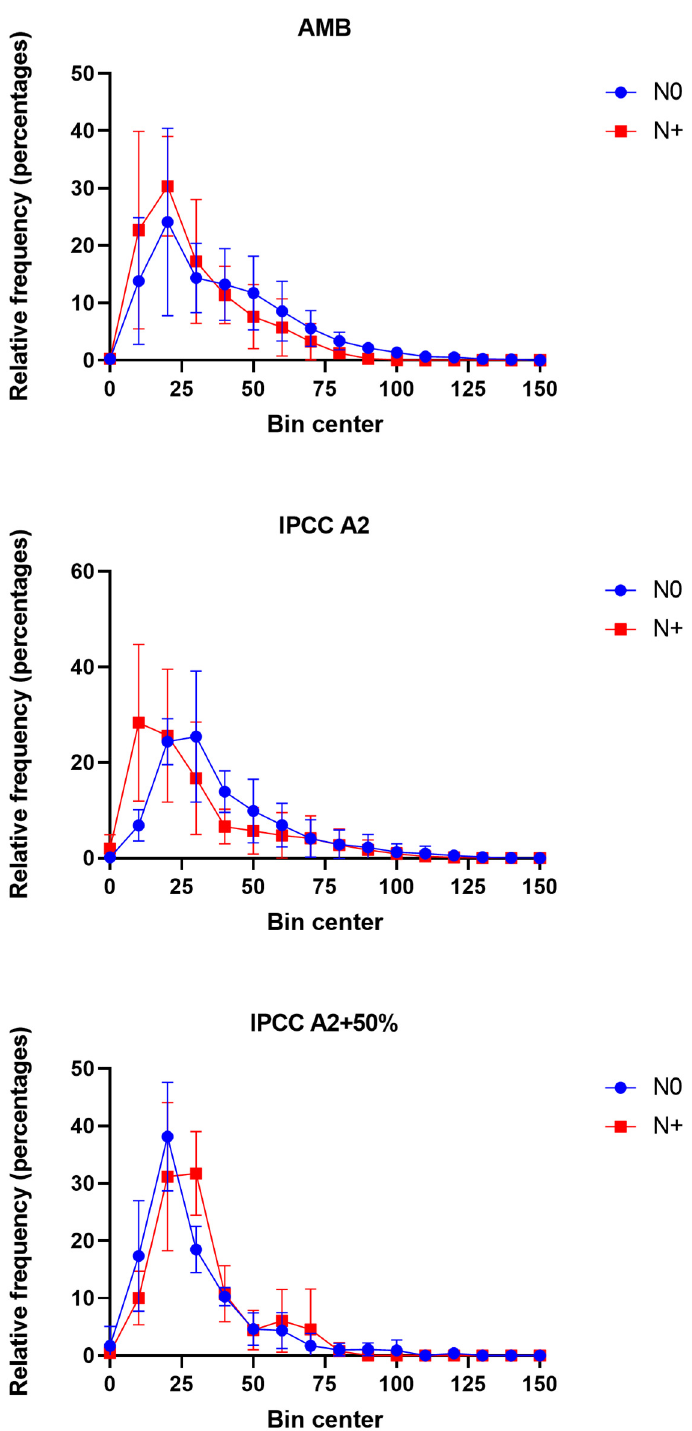
Figure 8. Phytoplankton (cell and colony) size distributions in AMB, IPCC A2, and IPCC A2 + 50% in the N0 and N+ treatments based on the average distributions of area-based diameter (ABD) in the individual tanks for the period mid-June–September. Each bin contains the number of size values in certain range of values. The bin width equals 10. Bars—SD of the mean. The size medians in AMB and IPCC A2 were similar and showed a decrease from 37 to 26 μ m in AMB and from 37 to 28 μ m in IPCC A2 in response to the N addition (Figure